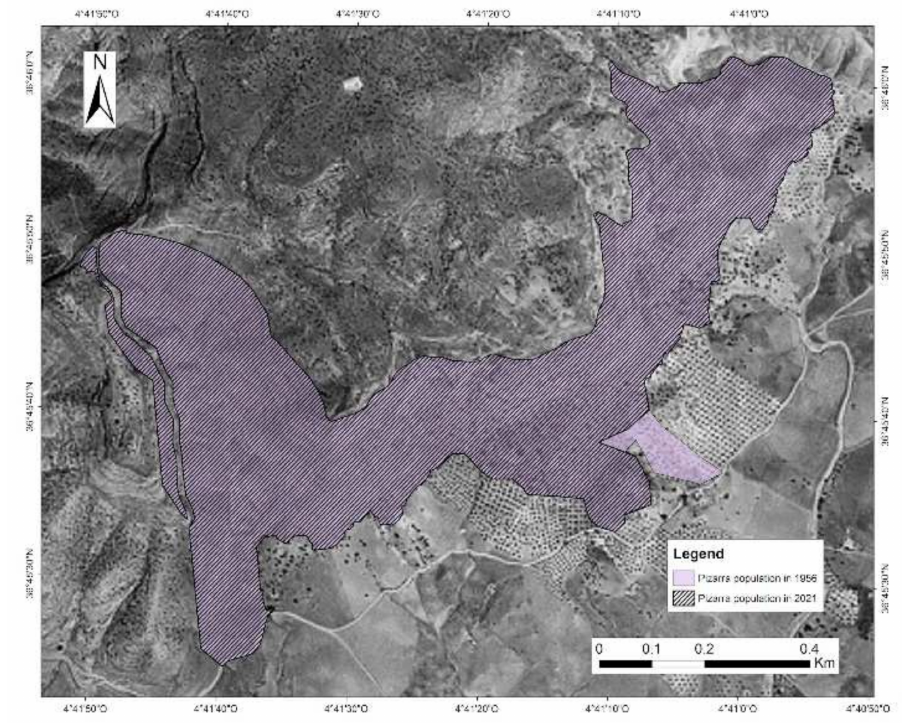
Figure 9. Pizarra 5220* HCI: Current and 1956–57 potential AOO.